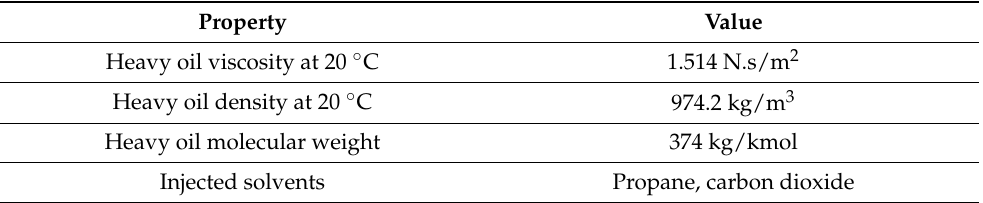
Table 1. The reservoir and fluid